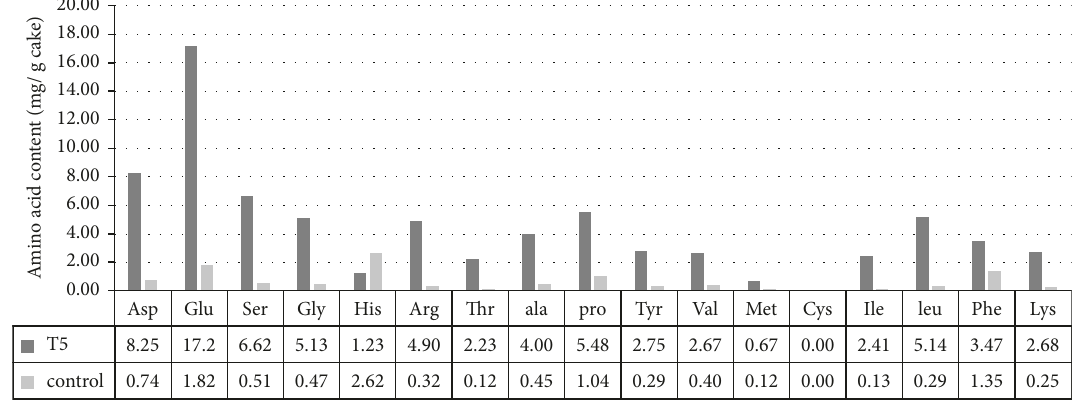
Figure 5: Comparison of amino acid profile of treatment No.5 (Selected treatment) with control sample. The amino acid profile was determined through HPLC method. The amounts of most of the essential amino acids were significantly more than control sample.